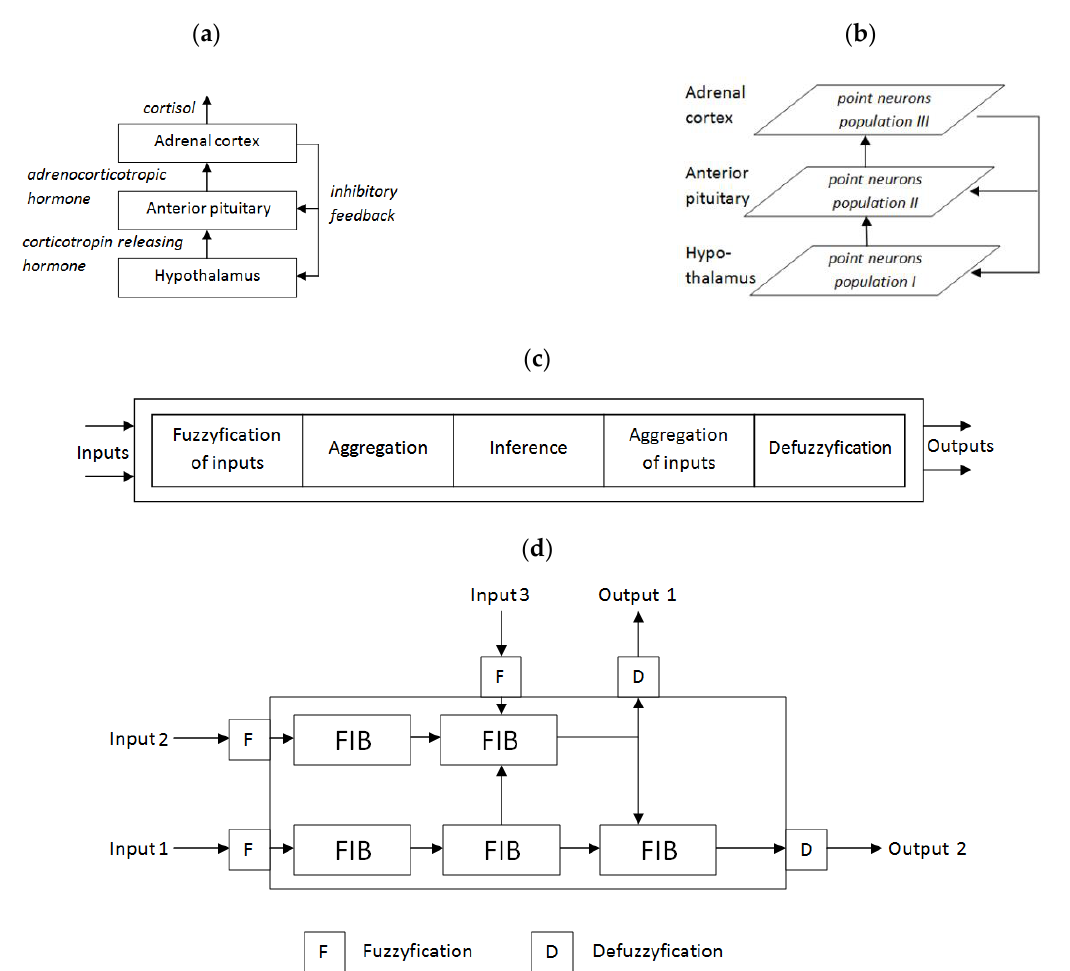
Figure 2. An example of the possible use of fuzzy systems in the computational model of the HPAaxis (own concept): ( a ) hypothalamic–pituitary–adrenal (HPA) axis, ( b ) traditional model based on point or compartmental neurons, ( c ) single fuzzy inference block (FIB), ( d ) complex fuzzy cascade model (CFCM)—own approach based partly on our previous own concept [44].